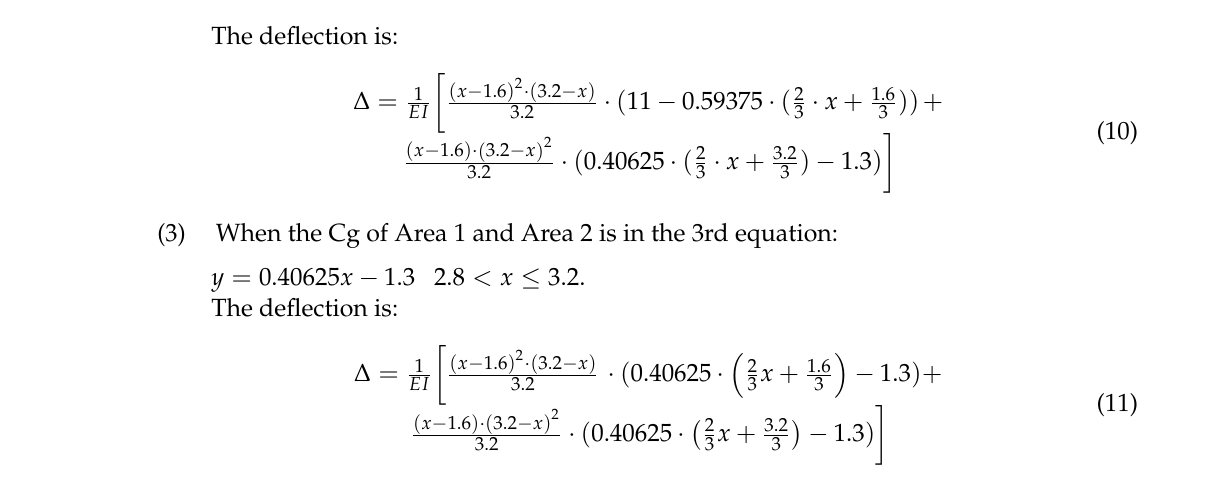
Figure 6. Midas civil model of test continuous beam. 3.1. Establishment of Multiple Damage Model As displayed in Figure 6, the idealized model of the continuous beam structure was that the UL acted on the central line of the beam. Locating the structure type to the X-Z plane could shorten the design process. To make the model easier to understand, C50 concrete under the JTG3362-18(RC) code was directly selected as the material, including the elastic modulus of concrete